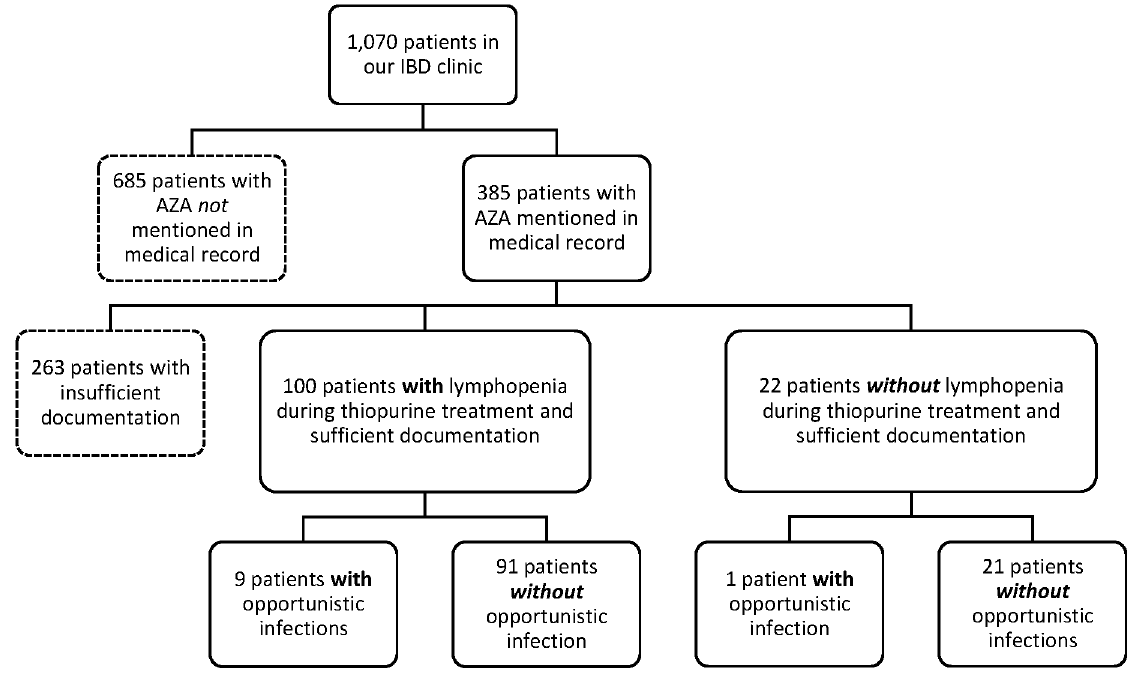
Fig 1. Selection process. This figure shows the patient selection process.